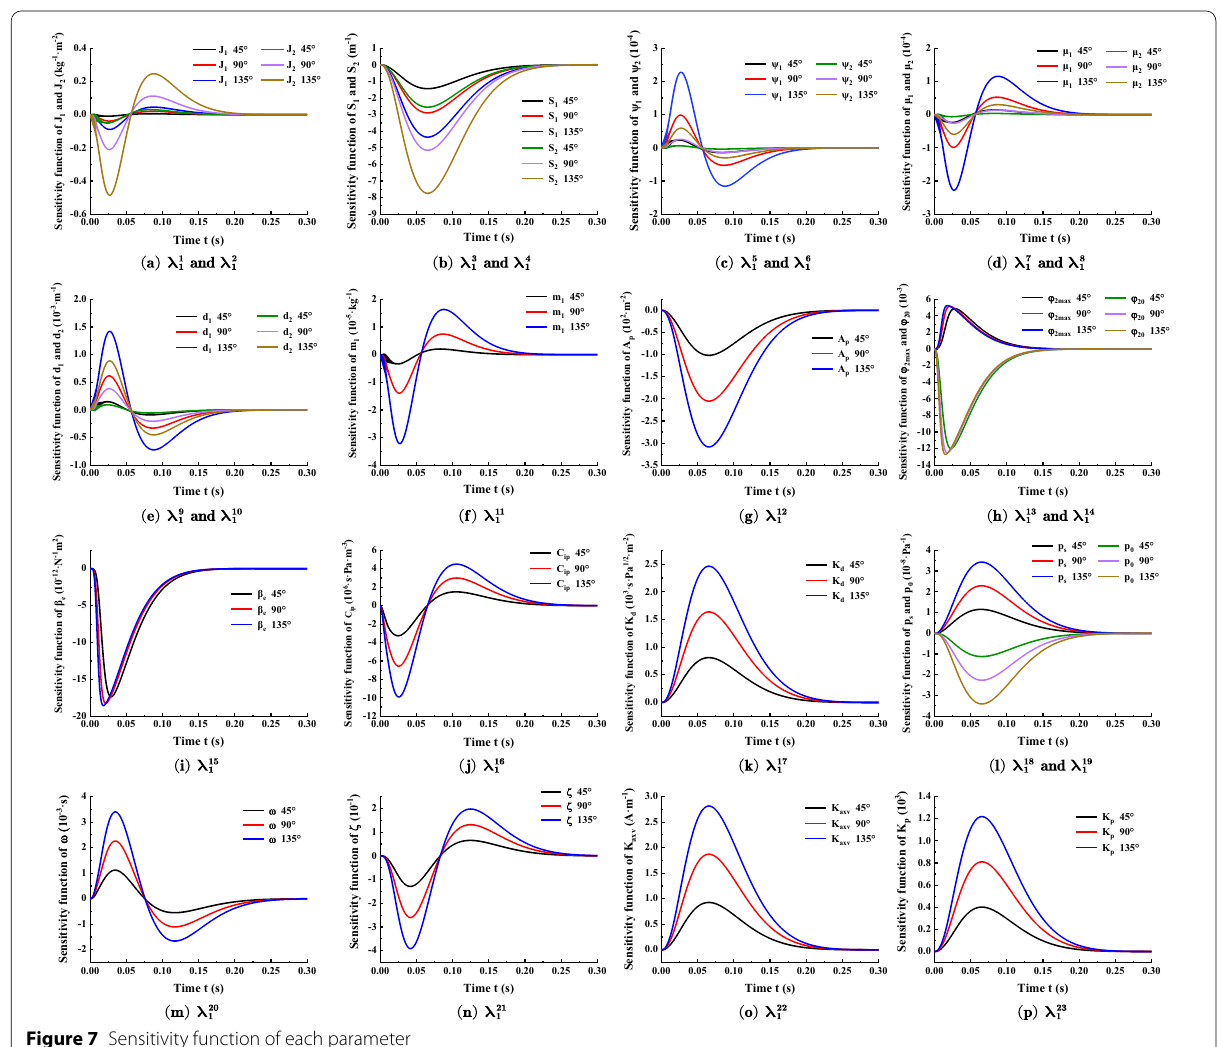
Figure 7 Sensitivity function of each